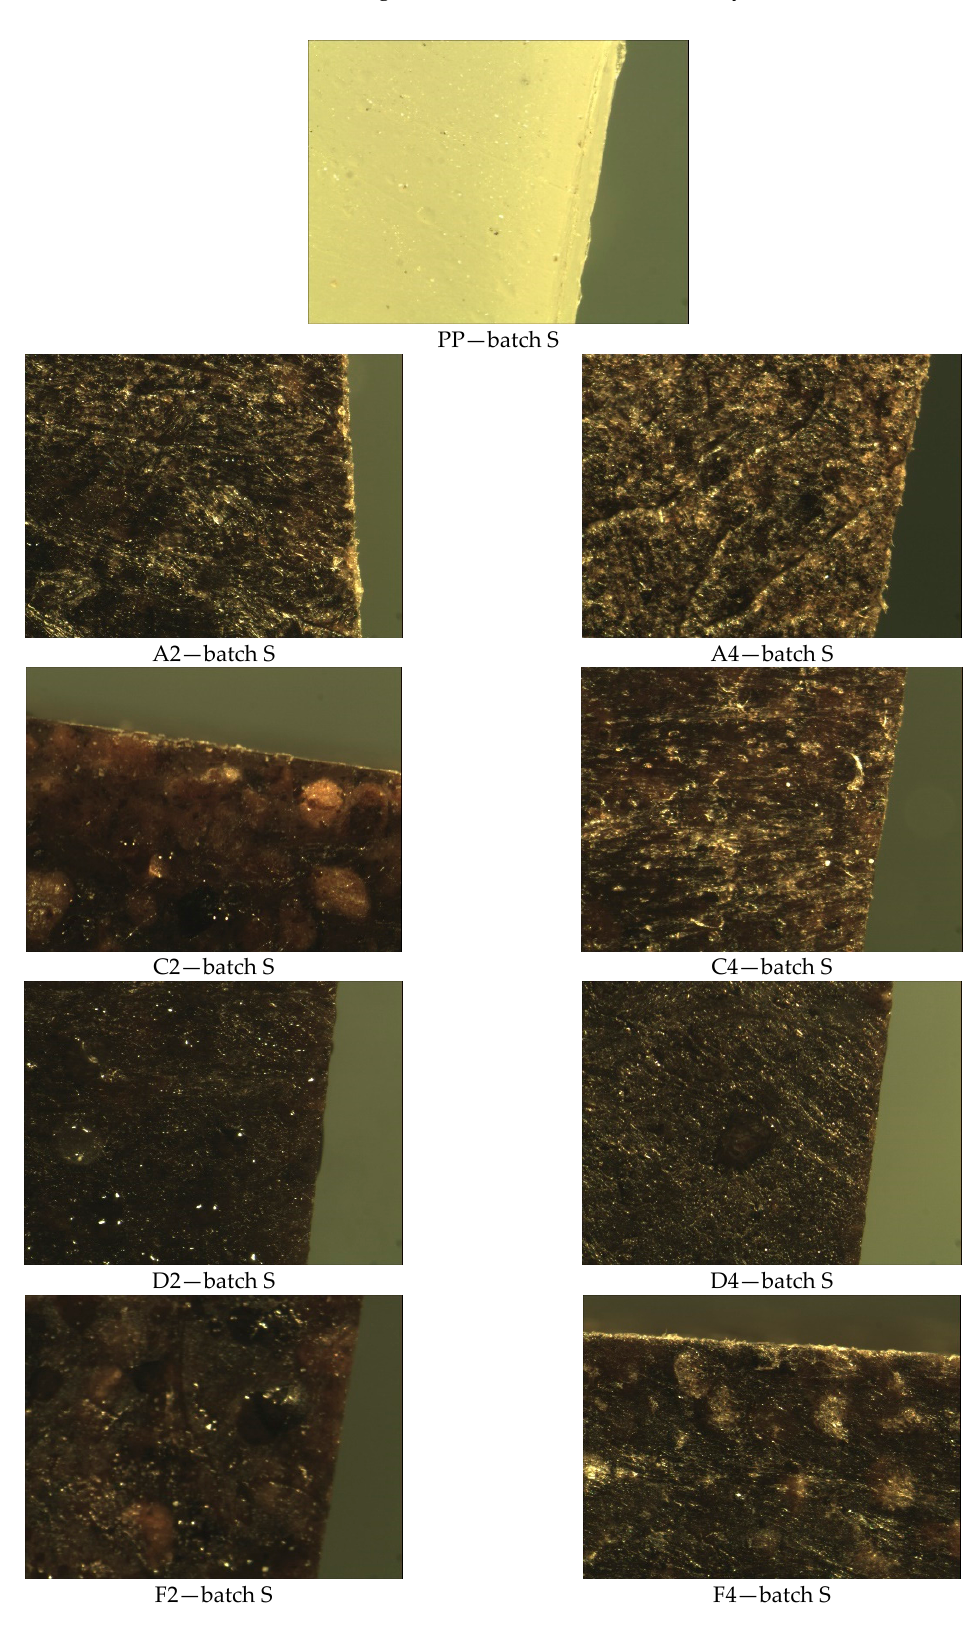
Figure 6. Results of microscopic evaluation of batch samples: S.